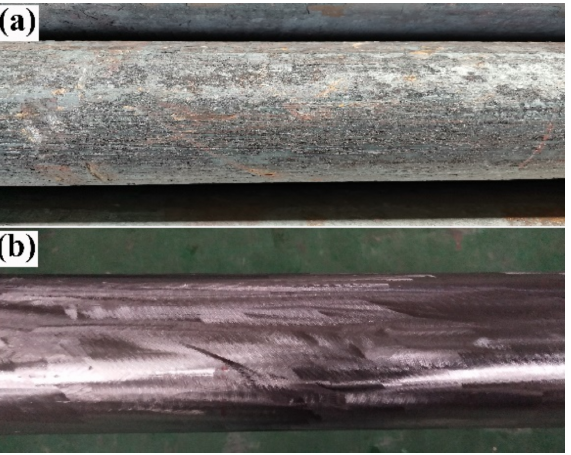
Figure 2. Image of the surface of a carbon steel mandrel before and after cleaning: ( a ) before cleaning; ( b ) after